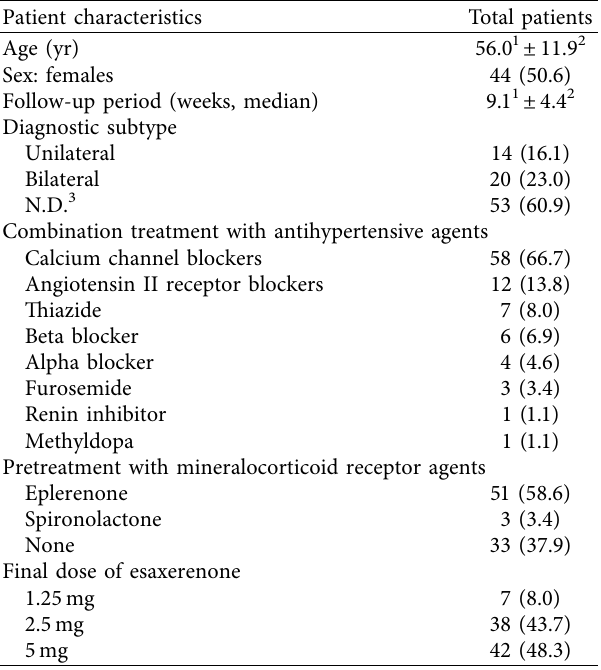
Table 1: Clinical characteristics of PA patients ( n � 87) that par- ticipated in the study. Values represent sample size ( n ) and percent (%), unless stated